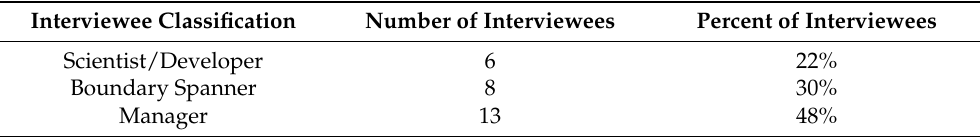
Table 2. Interviewee general classifications (as assigned or self-identified during interview). Scien- tist/developer refers to interviewees who primarily conduct research and may work in the Forest Service or external organization. Boundary spanner refers to interviewees who work to facilitate connections between scientists/developers and managers; they worked in both the Forest Service and partner institutions such as universities. Boundary spanners in the context of pre-fire planning in the U.S. are individuals who provide communication and translation functions that help to facilitate the exchange of knowledge to co-develop DSSs and bridge the spheres of science and management. Manager refers to interviewees who make fire or forest management decisions and work for the Forest Service.